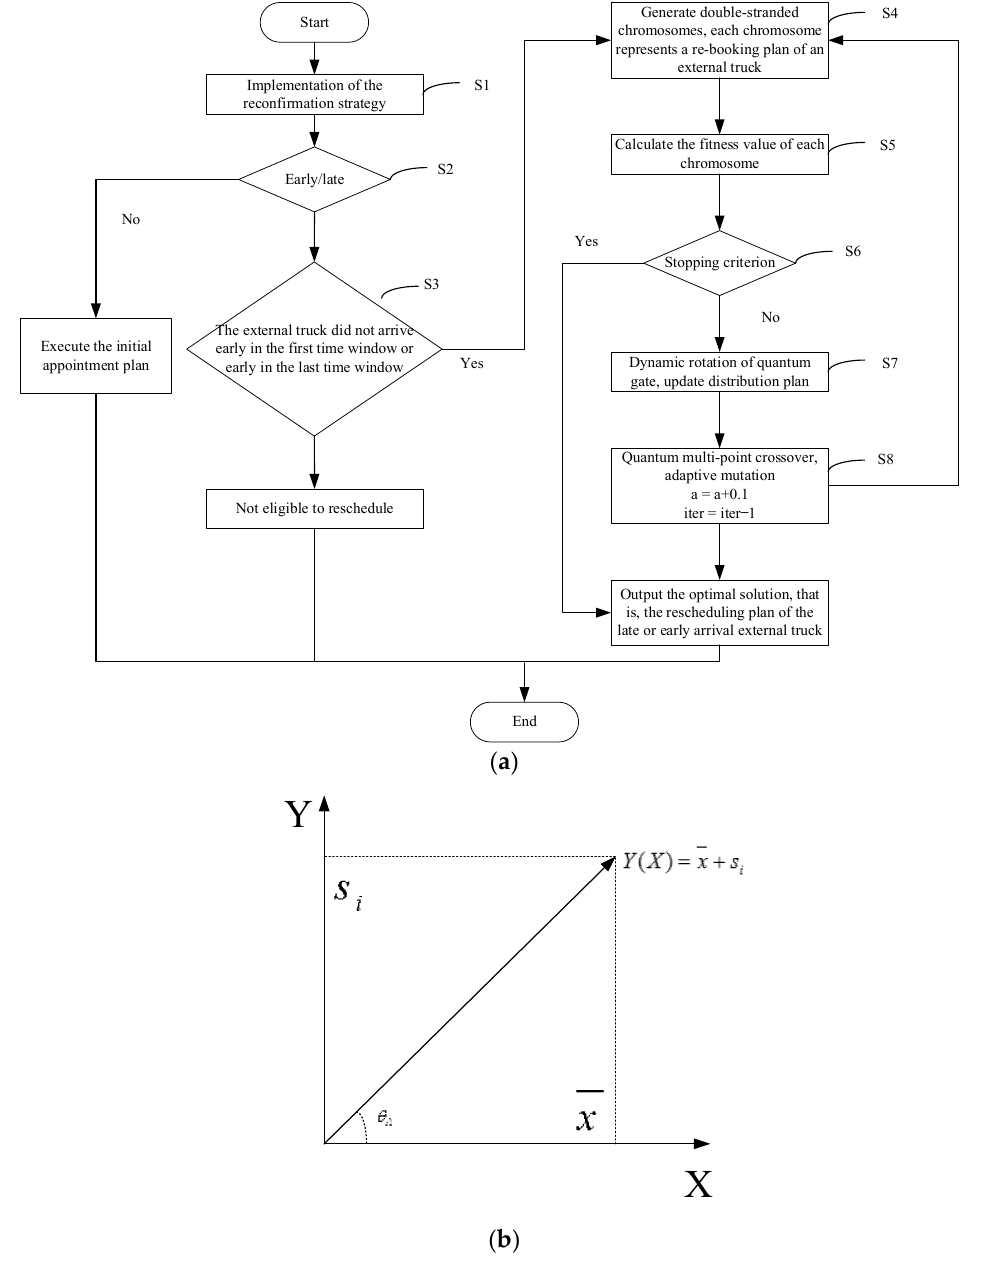
Figure 2. Algorithm flow chart and explanation of fuzzy number space. ( a ) Algorithm flowchart; ( b ) fuzzy number space interpretation.